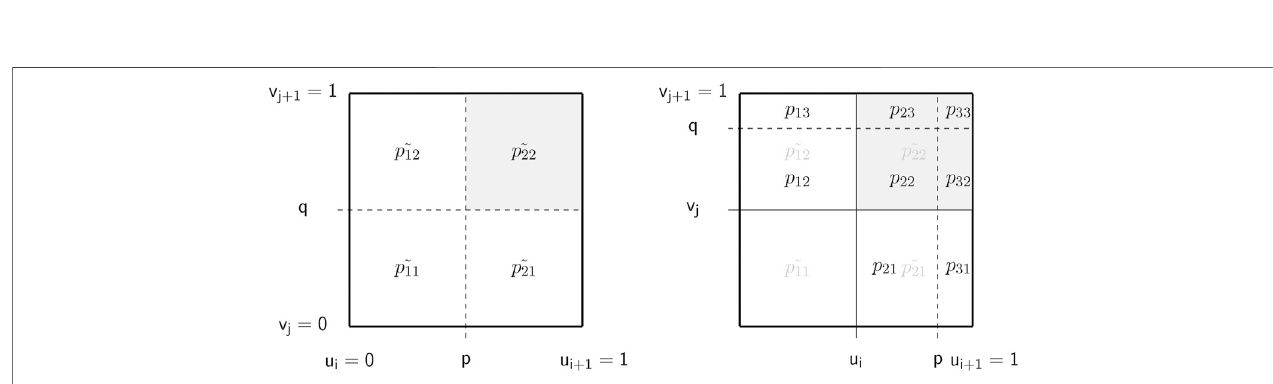
FIGURE 8 | Quantile partition of the joint distribution from ( i ) to ( iv